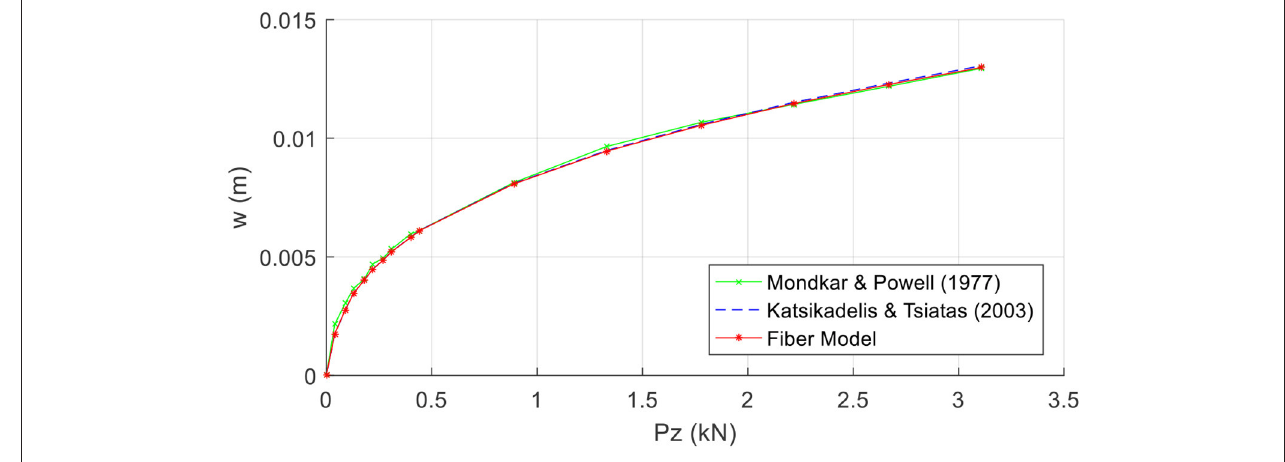
FIGURE 5 | Deflection versus Load at the center of the beam in Example 1.